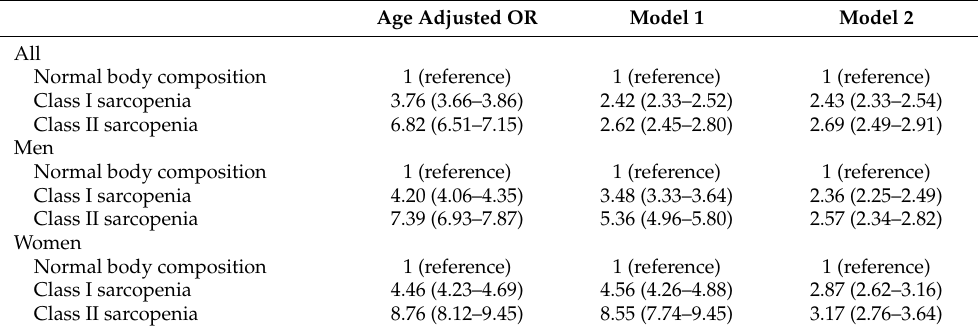
Table 3. Adjusted ORs (95% CI) of metabolic syndrome according to sarcopenia status in study subjects. Age Adjusted OR Model 1 Model 2